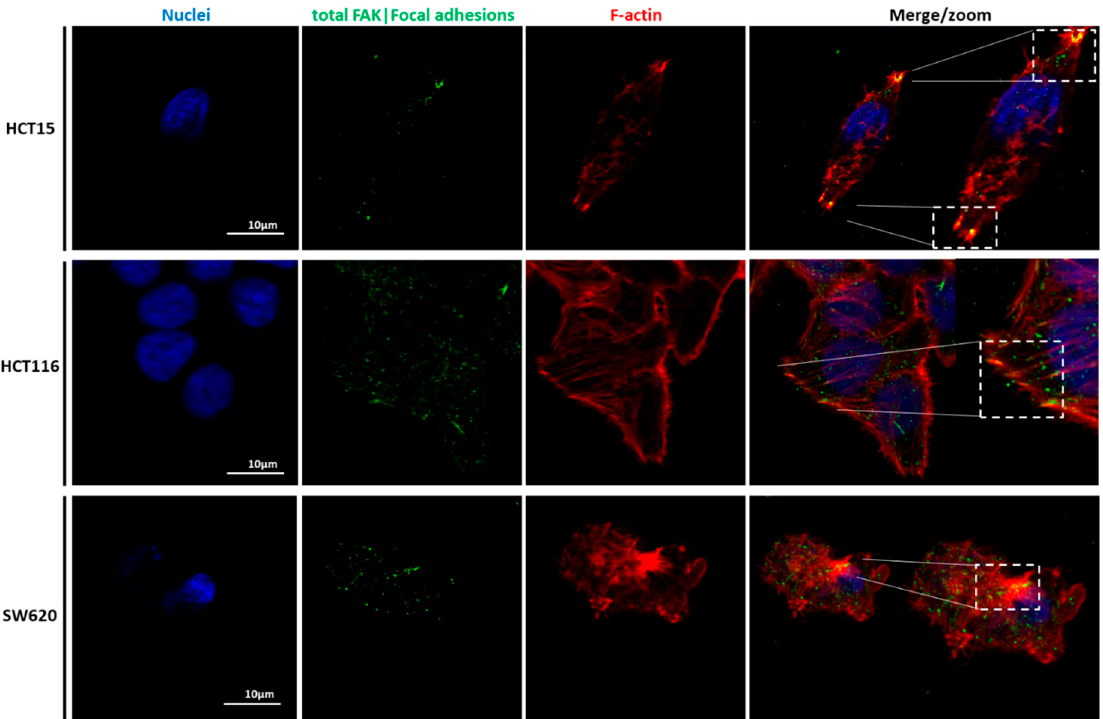
Figure 9. Illustration of the focal adhesion sites of CRC cells seeded in 2D. Immunolocalization of nuclei (blue), phosphorylated FAK (green), and F-actin filaments (red) in HCT15 ( top ), HCT116 ( middle ), and SW620 ( lower images ) cell lines. The zoomed areas indicate the co-localization of FAK with the F-actin filaments at the focal adhesion complexes located at the bottom z-stack. Scale bars: 10 µm.